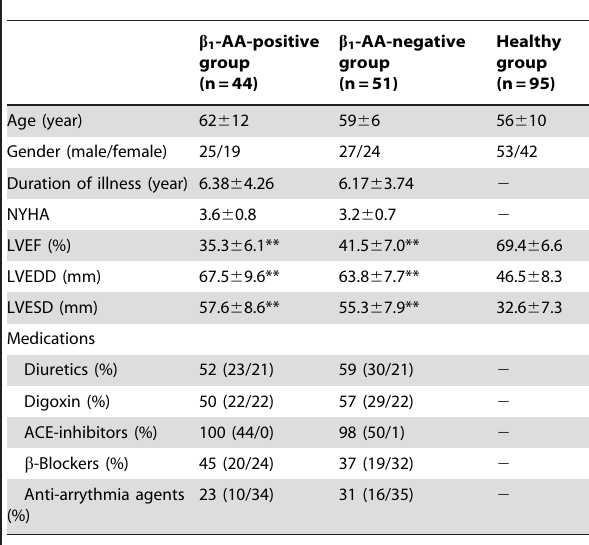
Table 1. Clinical characteristics of patients with chronic heart failure due to DCM (mean 6